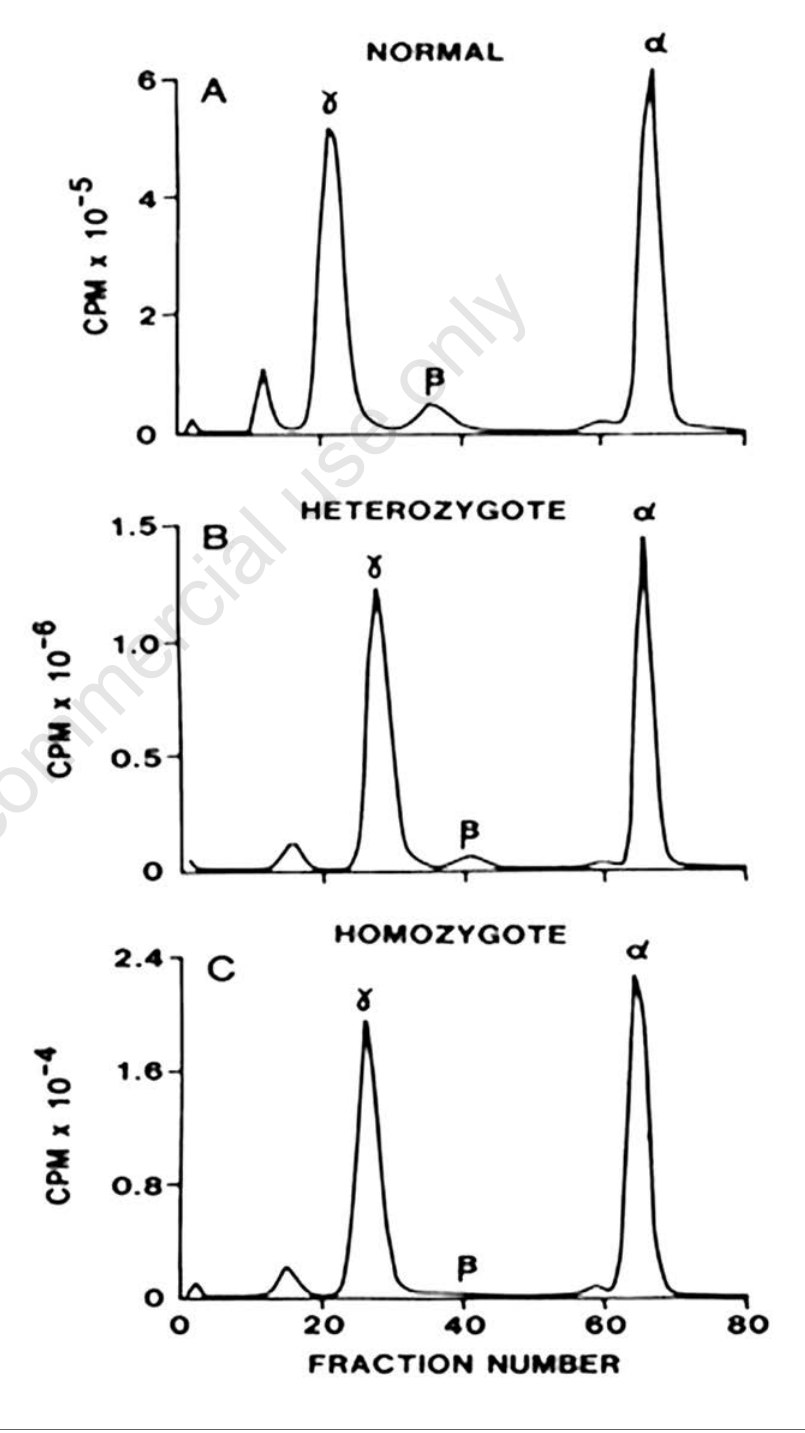
Figure 2. Globin gene chains separations by carboxymethyl cellulose